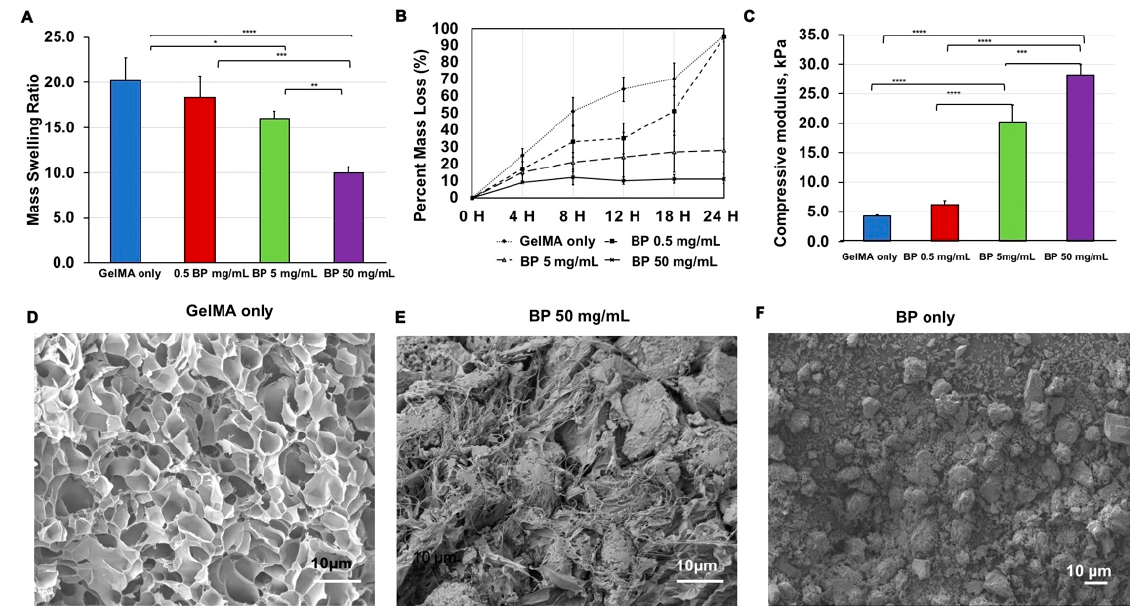
Figure 1. Characterization of the physical properties of GelMA/BP composite hydrogels. ( A ) Swelling analysis showed mass swelling ratios decreased with increased BP microparticle concentrations (Error bars: ± SD, * p < 0.05, ** p < 0.01, *** p < 0.001, and **** p < 0.0001). ( B ) Enzymatic degradation and ( C ) Compressive moduli analysis also revealed tunable behaviors based on the hydrogel composition. (Error bars: ± SD, *** p < 0.001 and **** p < 0.0001). Scanning Electron Microscopy (SEM) images of ( D ) GelMA only, ( E ) BP 50 mg/mL and ( F ) The BP only.